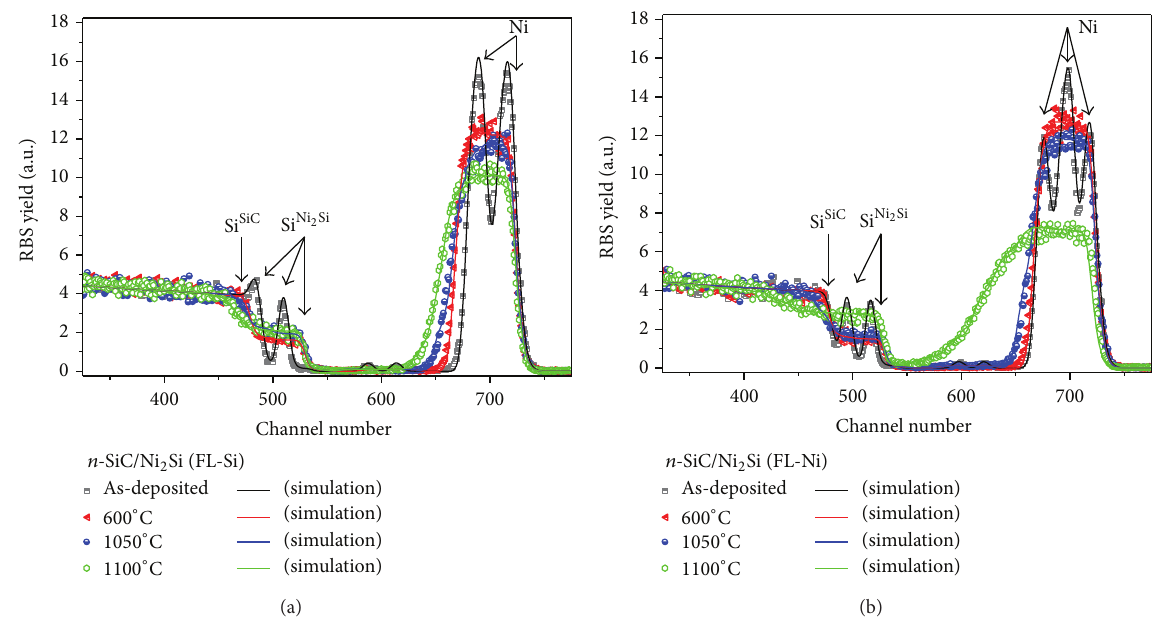
Figure 3: RBS spectra for as-deposited and annealed at 600 ∘ C, 1050 ∘ C, and 1100 ∘ C contacts: (a) n -SiC/Ni 2 Si with FL-Si; (b) n -SiC/Ni 2 Si with FL-Ni